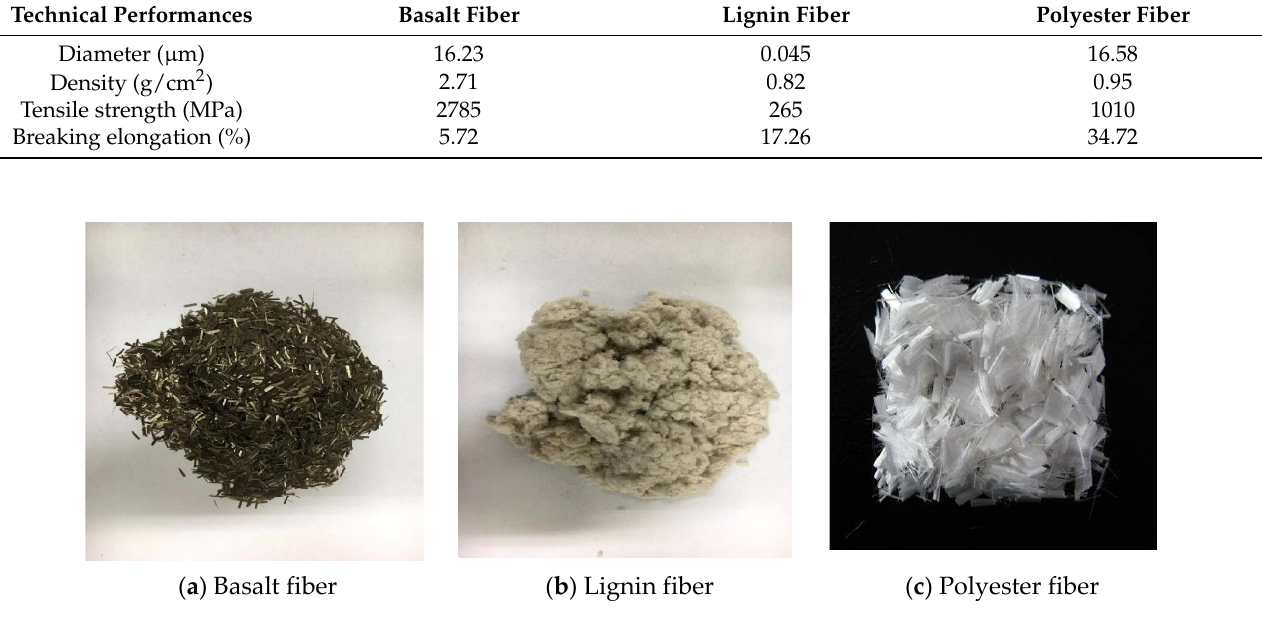
Figure 8. Morphology of used fibers.